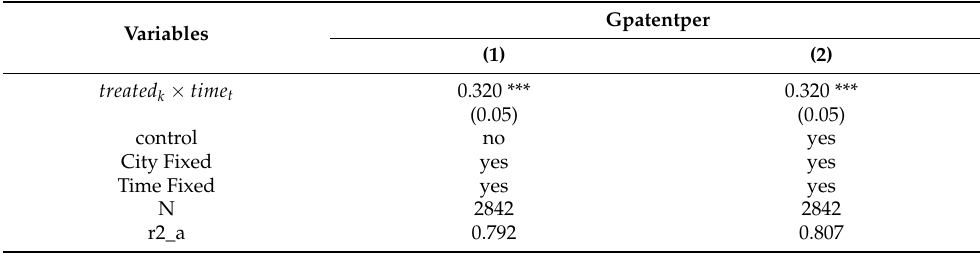
Table 5. PSM-DID regression results.